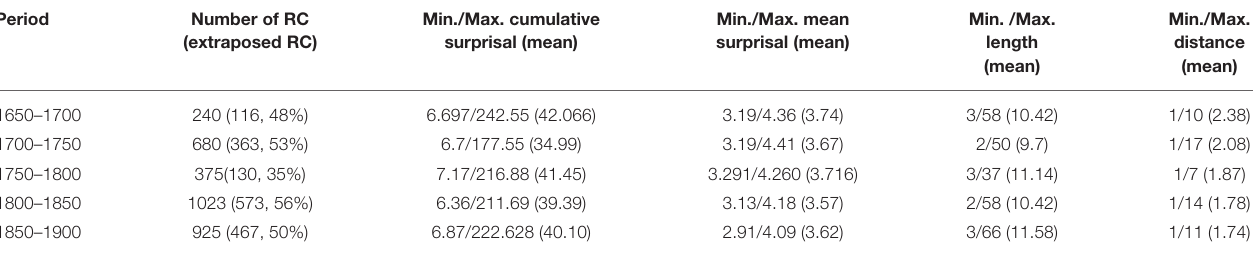
TABLE 4 | Descriptive statistics. Period